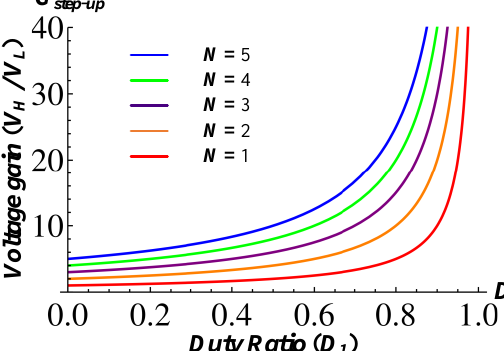
Figure 8. Voltage gain of the proposed topology in the step-up